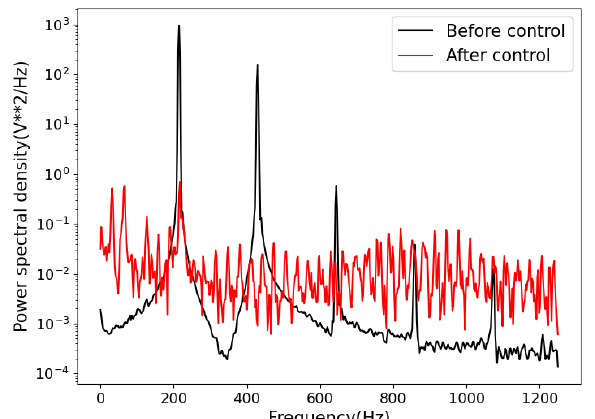
Figure 10. Power spectral density of pressure signal with and without discharge.